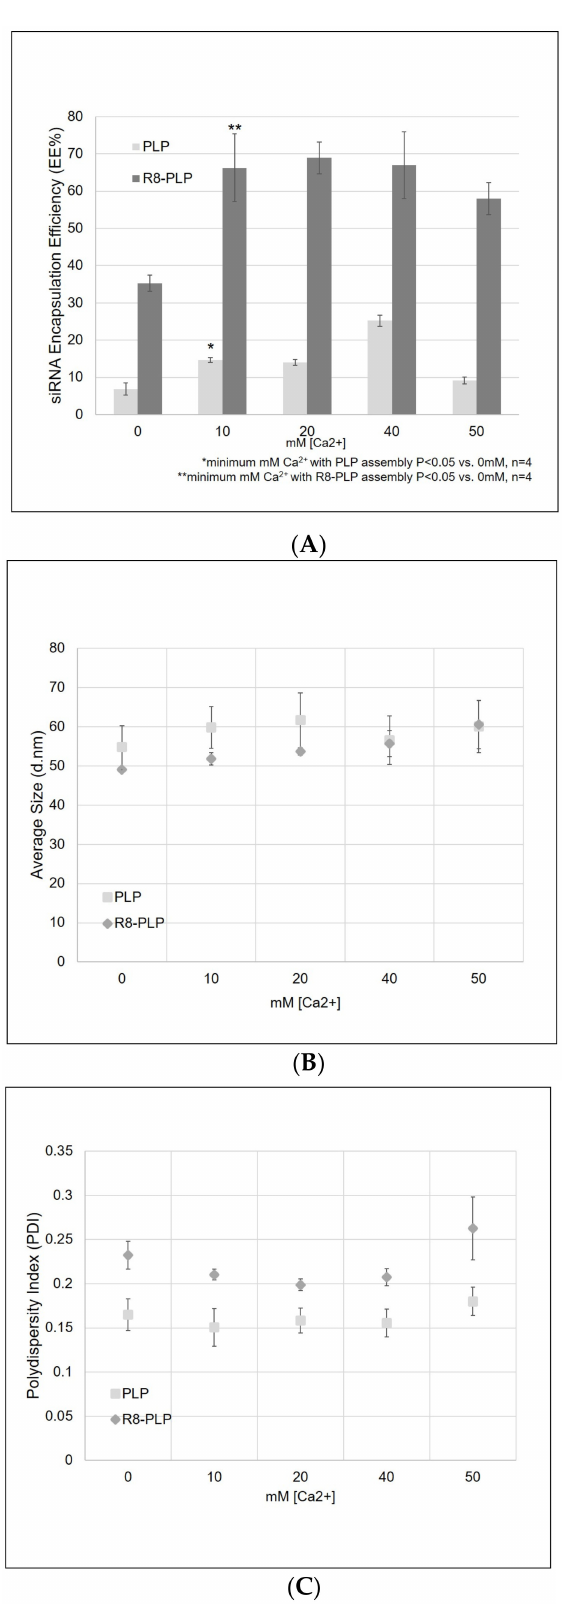
Figure 3. Ca 2+ -mediated EtOH injection of R8-PLPs resulted in ( A ) increased siRNA retention and EE% in ( B ) 50–60nm liposome samples with a ( C ) homogeneous size